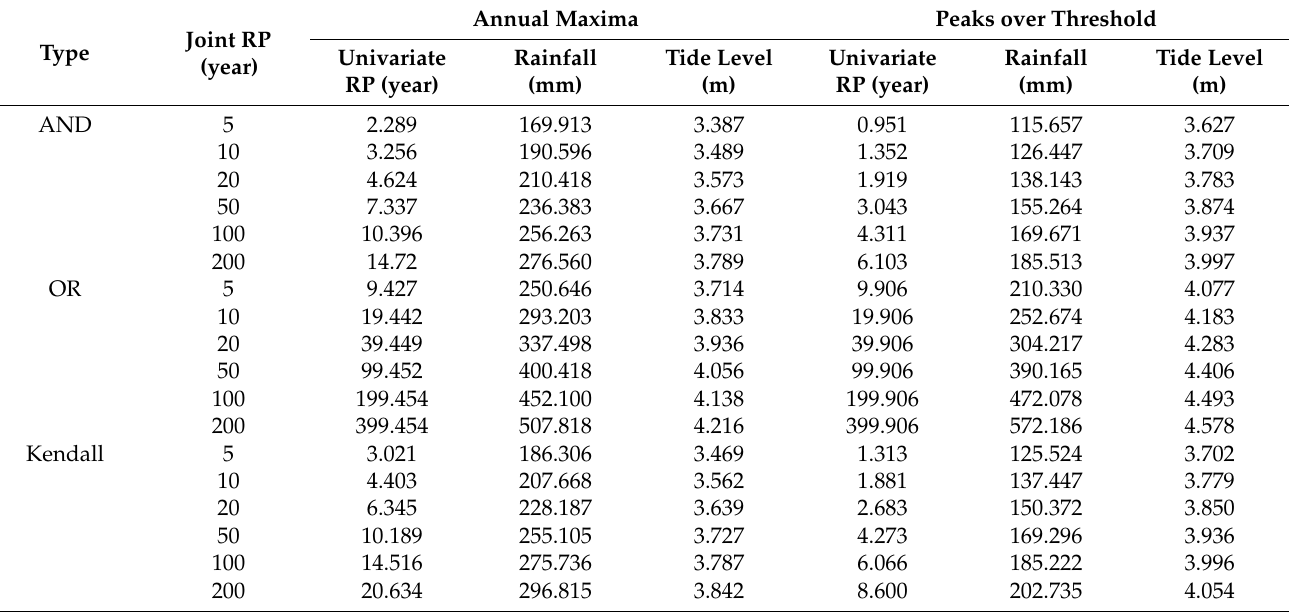
Table 7. Design rainfall and tide levels of different joint return periods for the different sampling